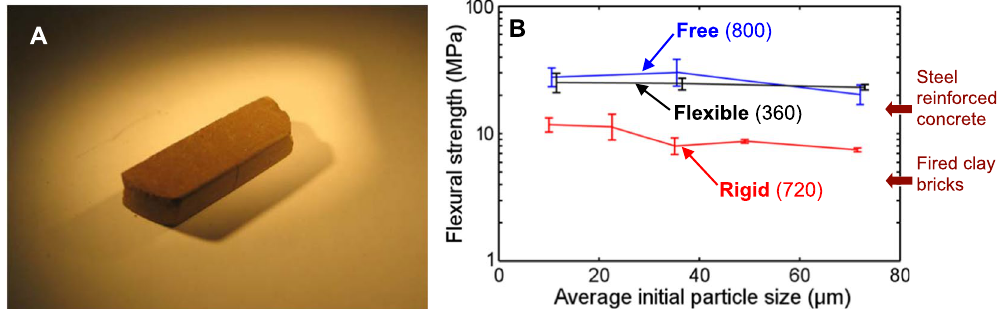
Figure 1. ( A ) A photo of solid Mars-1a beam quasi-statically compacted with rigid boundary condition. The curved ends show the boundaries of the steel mold. The width of the sample is ~1 cm. ( B ) Flexural strength of compacted Mars-1a as a function of the initial average particle size. The average particle sizes are computed as the nominal midpoint for each fractioned sieve size, i.e. the arithmetic mean of the bin sizes. The three series represent the three lateral boundary conditions (names in bold) with the maximum compression pressure (in MPa) inside parentheses.